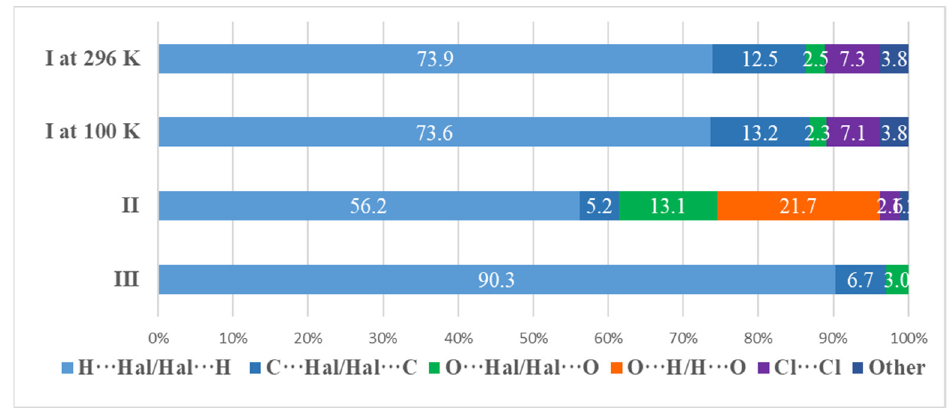
Figure 8. Percentage contributions to the Hirshfeld surface area for the various close intermolecular contacts for anions in I - III .